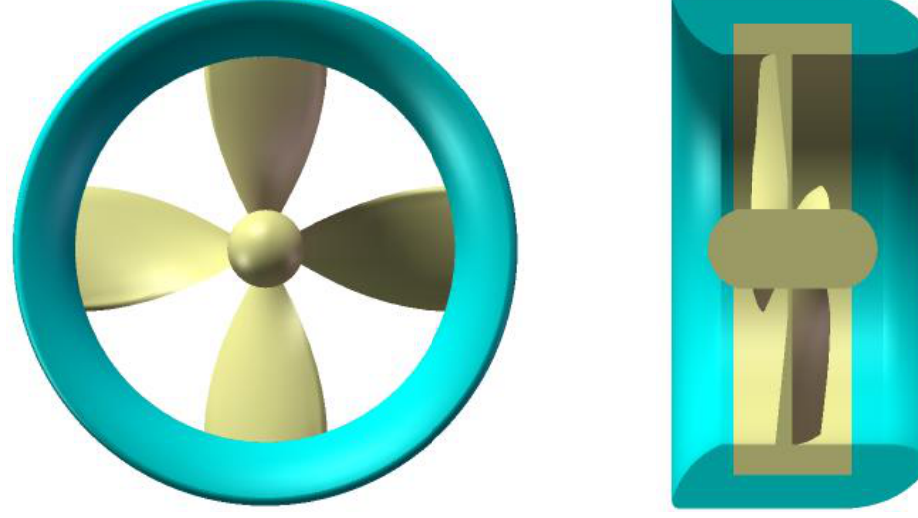
Figure 9. Optimized RDT model.